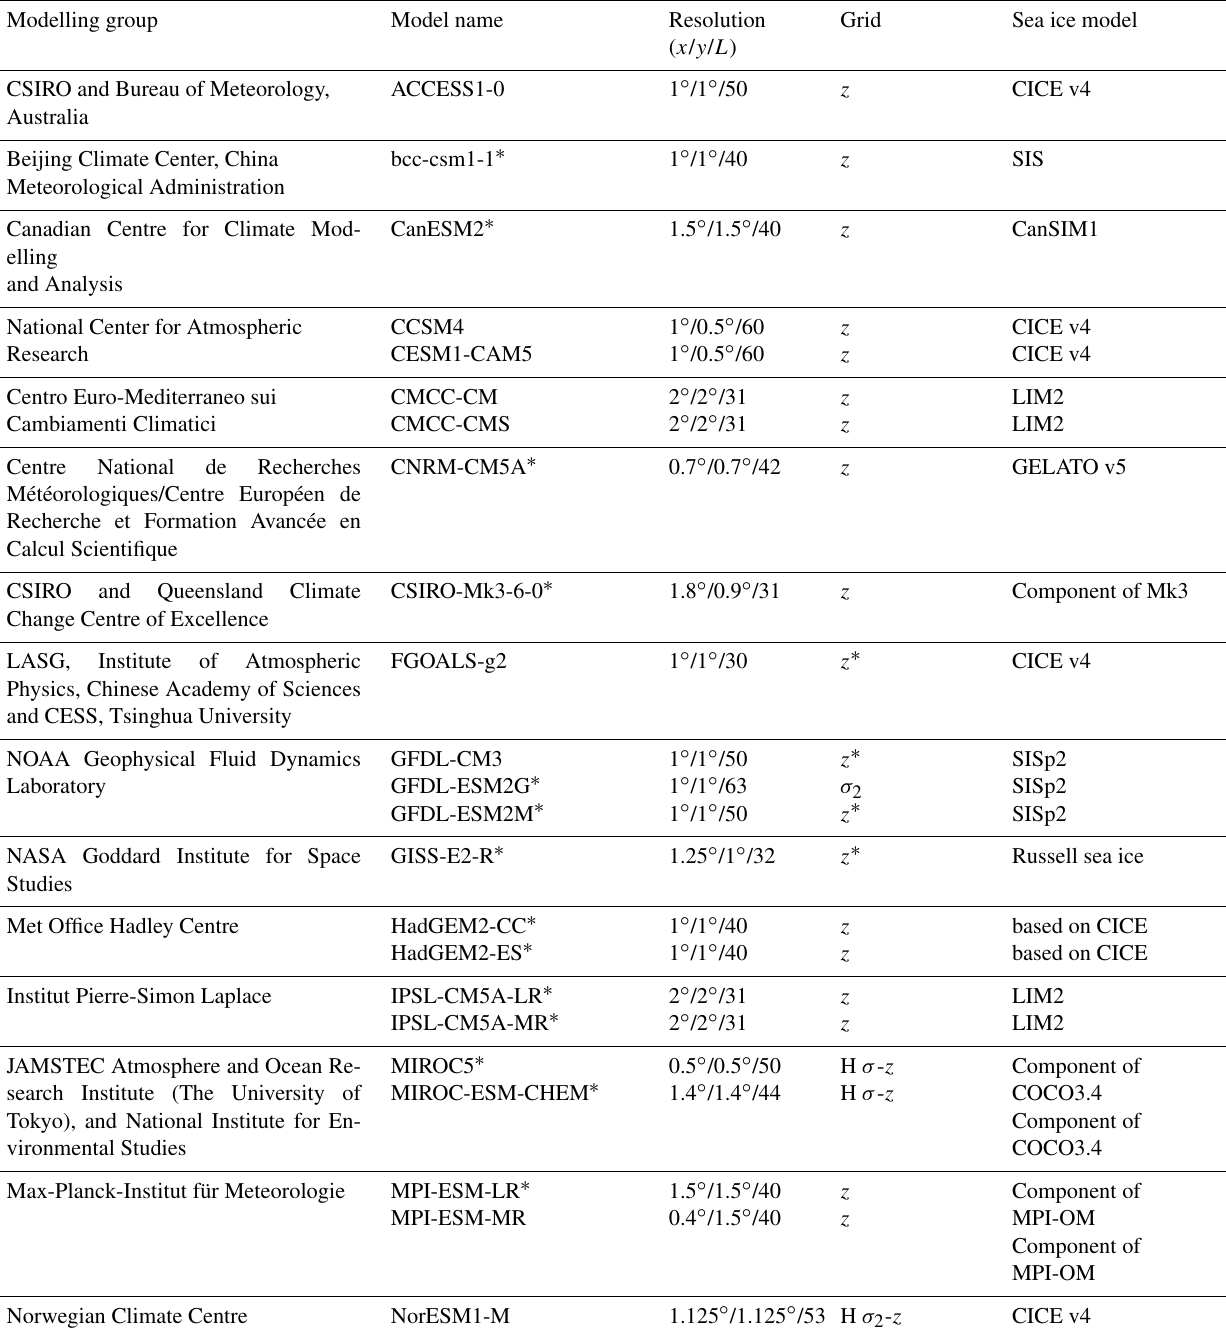
Table 1. List of CMIP5 models (Taylor et al., 2012): modelling groups, model names, ocean resolution in the North Atlantic (longi- tude/latitude/number of depth levels), type of vertical grid in the ocean ( z is geopotential, z ∗ is geopotential with free sea surface, σ is terrain following, σ 2 is isopycnic, and H denotes an hybrid grid), and sea ice component. Stars ∗ indicate the models whose pre-industrial control run is used in Sect.